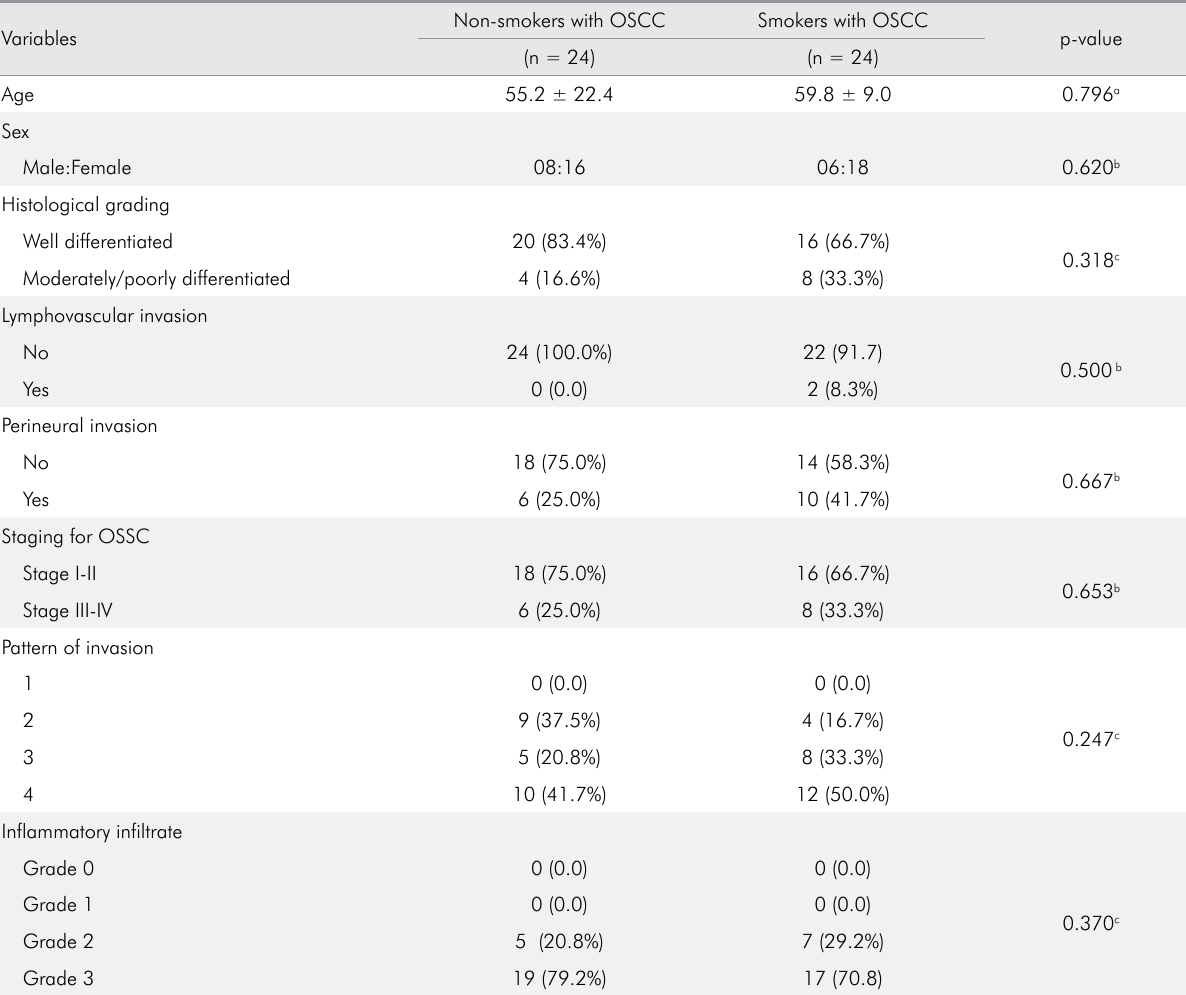
Table 1. Clinical and microscopic findings in the different groups with oral squamous cell carcinoma.